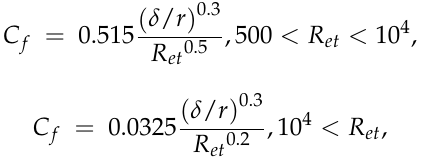
Table 3. Loss distribution of HSPMSMs with different rotors.